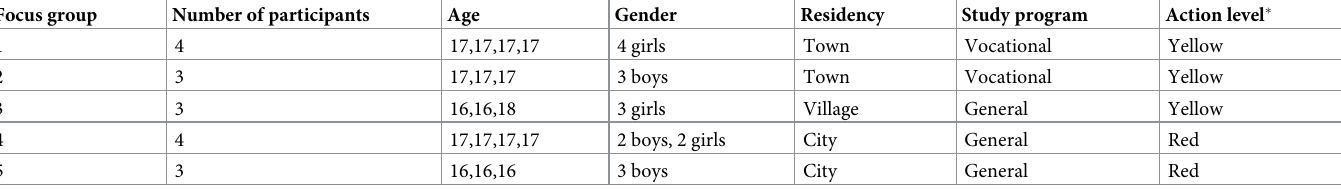
� Schools are graded by green, yellow and red action levels: green level = schools can be organized as normal; yellow level = a class is considered a cohort and measures are to be taken to limit the contacts between cohorts; red level = students are divided into small groups, which leads to restricted school attendance in order to keep the distance required